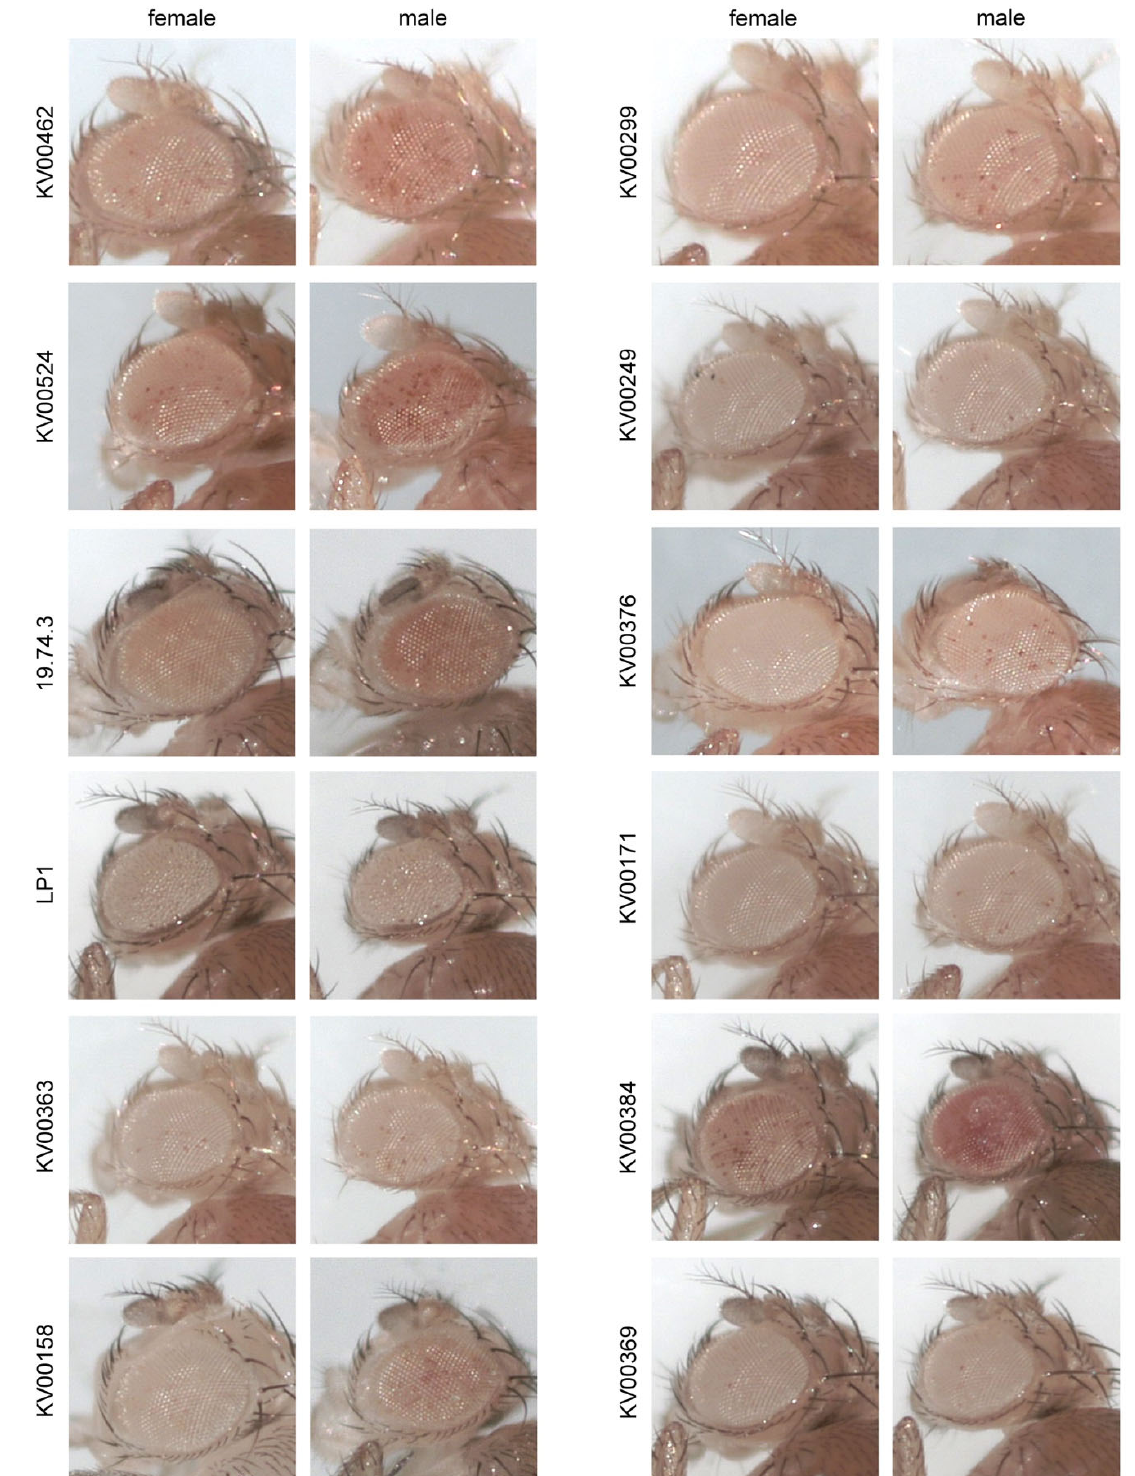
Figure 2. Strong silencing of Pw + reporters. Phenotypic analysis of the 12 lines carrying a single Pw + reporter inserted in constitutive heterochromatin of chromosome 2. All the Pw + reporters are balanced over the SM1, Cy chromosome and exhibited a strong silencing giving rises to extremely variegated eyes which in some cases are almost white. The males of lines KV00462, KV00524, 19.74.3 KV00158 and KV00384 exhibited a stronger red ‐ eye pigmentation compared to that of females, a difference that could be due to the presence of Y chromosome.